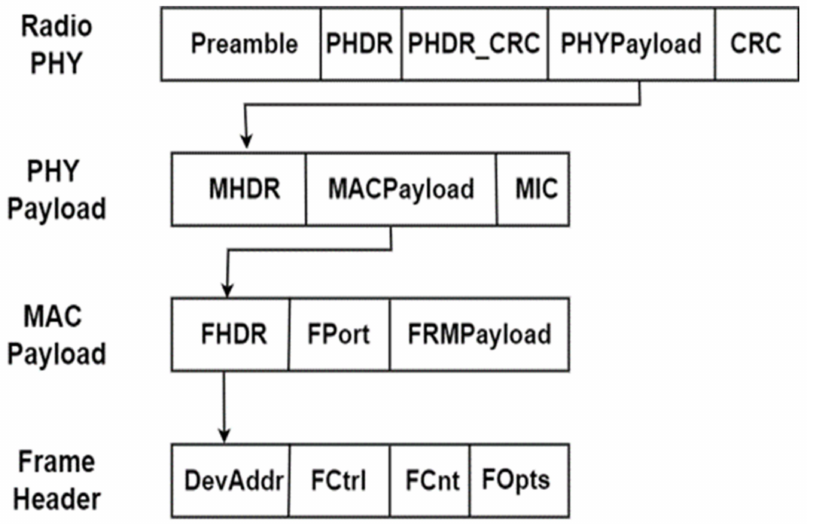
Figure 4. LoRaWAN MAC frame